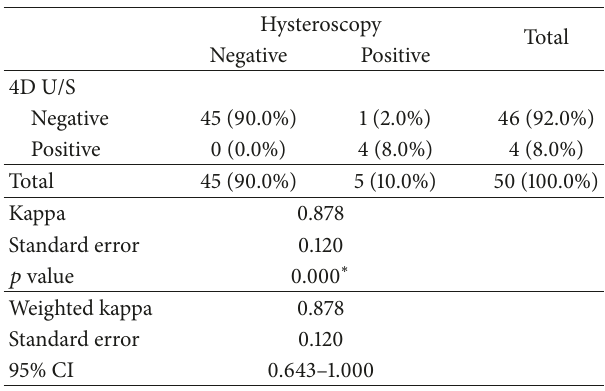
Table 2: Overall diagnosis (success of hysteroscopy to diagnose polyps as well as uterine anomalies).